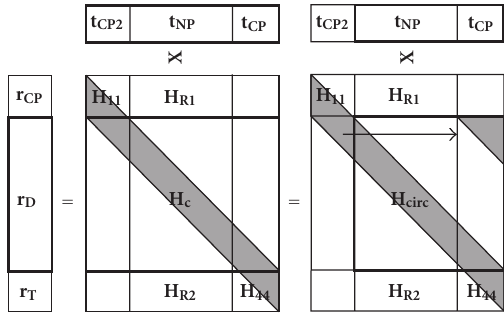
Figure 8: Theoretical background for equalization: selecting the correct submatrix H c of channel convolution matrix H . The circulant property is a result of cyclic prefix insertion in transmitter and proper subblock selection in the receiver. Vector t is transmitter output and r receiver input. The bold framing indicates subblock selection. The gray area represents nonzero